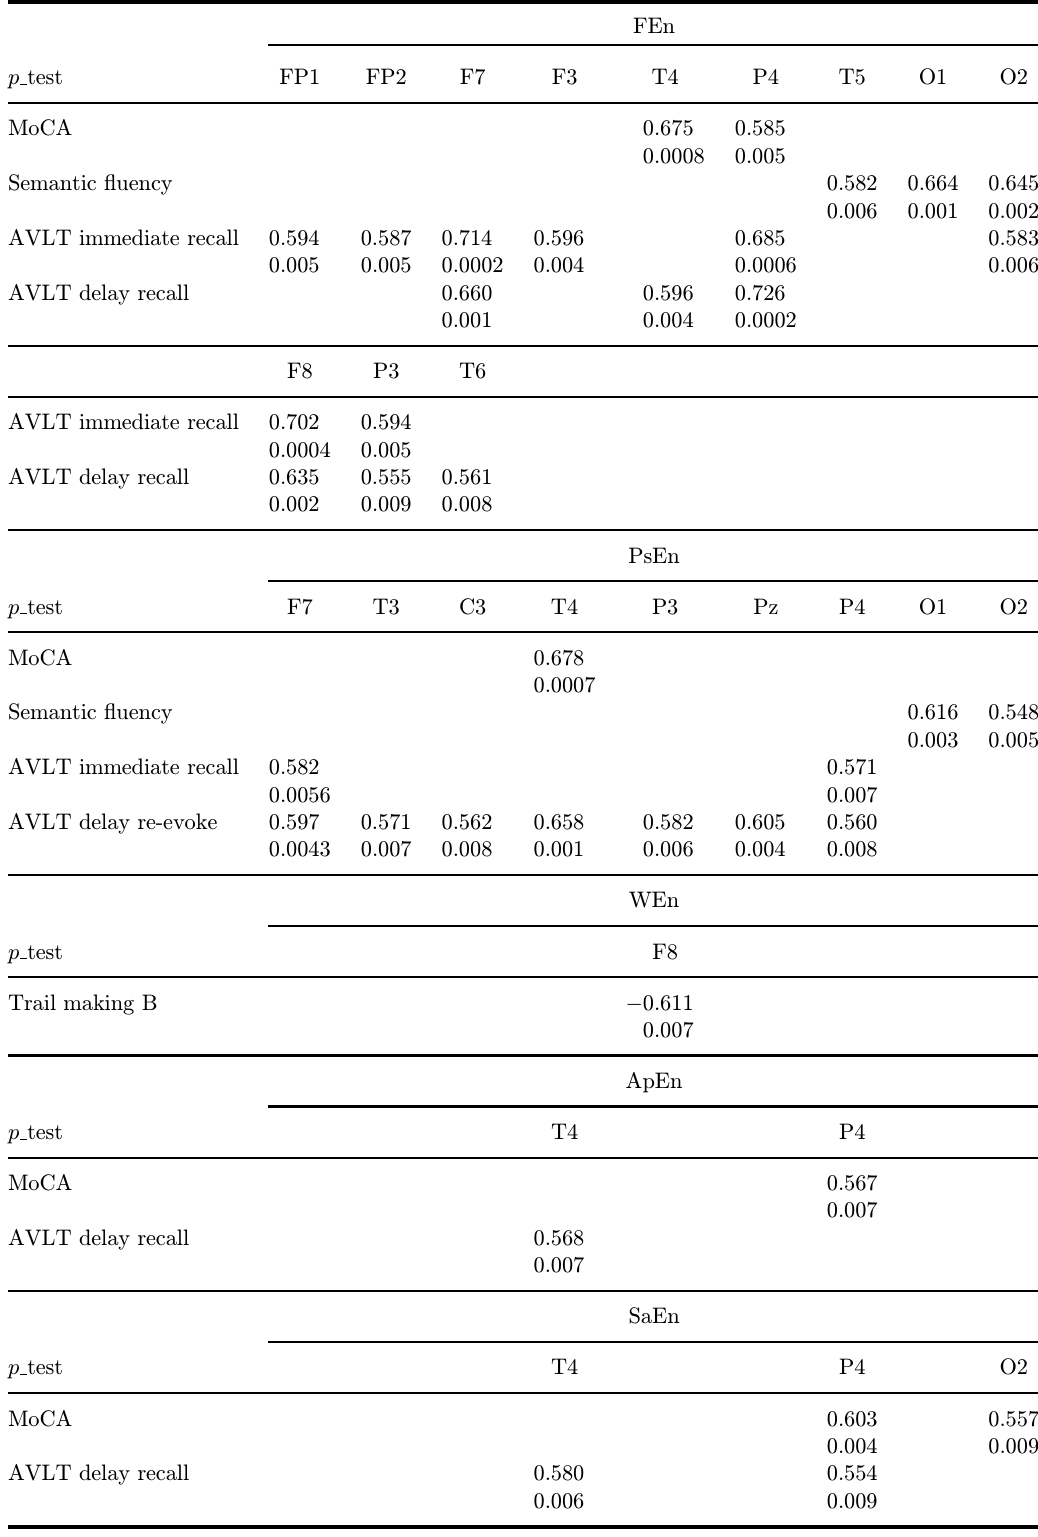
Table 5. Pearson's correlation analysis ( r and p values) between each entropy and the scores of the neuropsychological tests in all subjects as a whole group ( p < 0 :